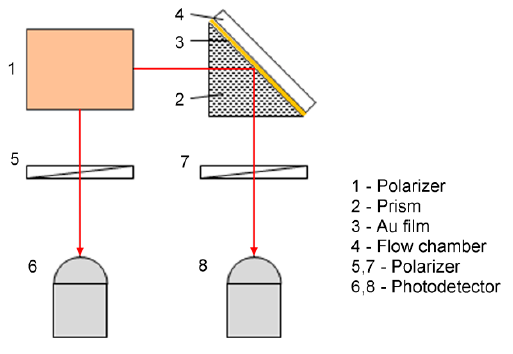
Figure 2. Heterodyne interferometry scheme used for SPR phase interrogation (Adapted from [35]).